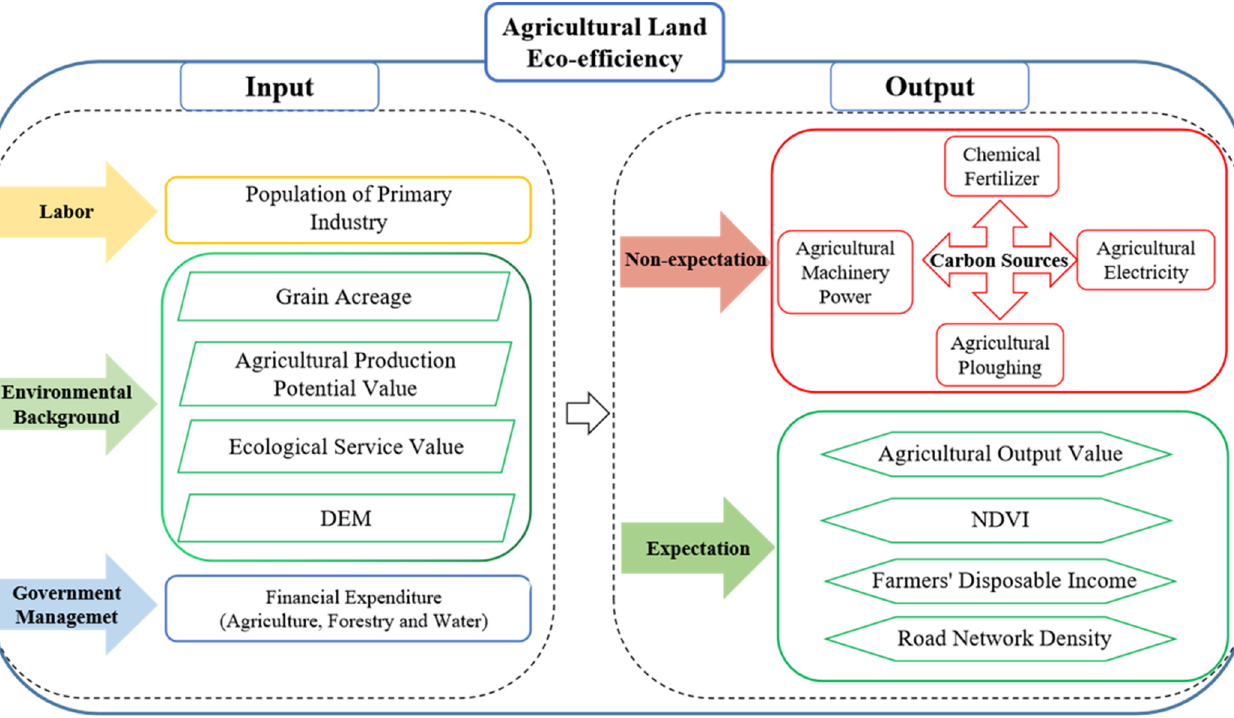
Figure 3. Calculation scheme of agricultural land eco-efficiency.